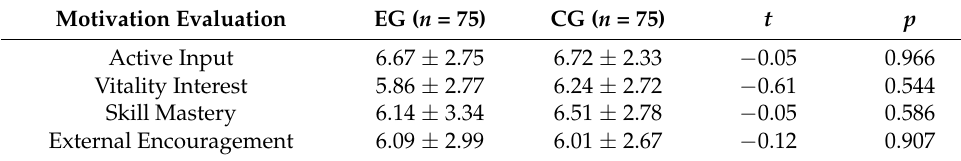
Table 5. Comparison of Motivation Evaluation Variables before Experiment